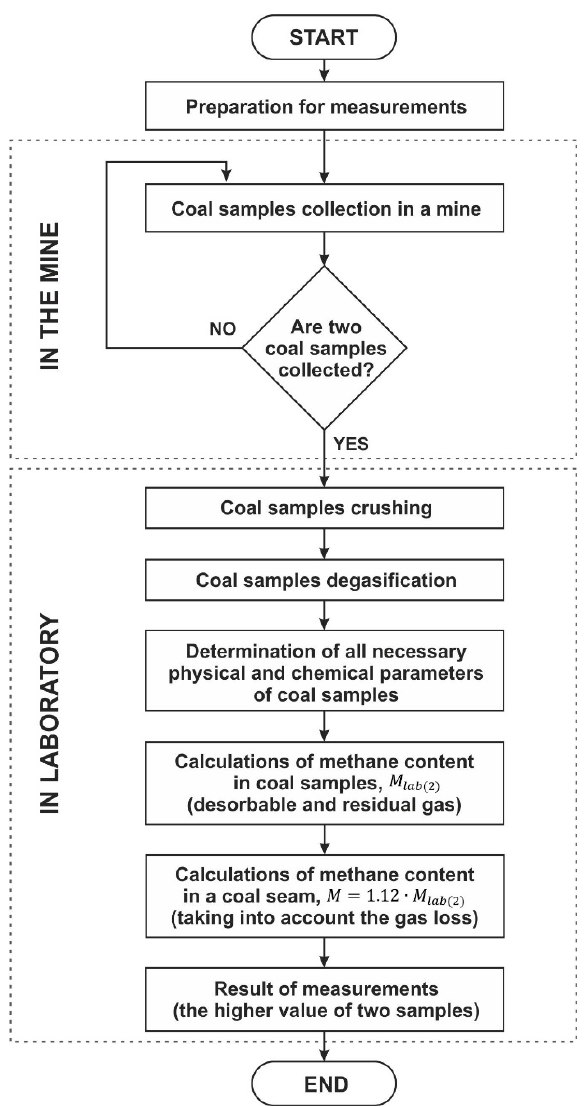
Figure 9. Flowchart of determining methane content.